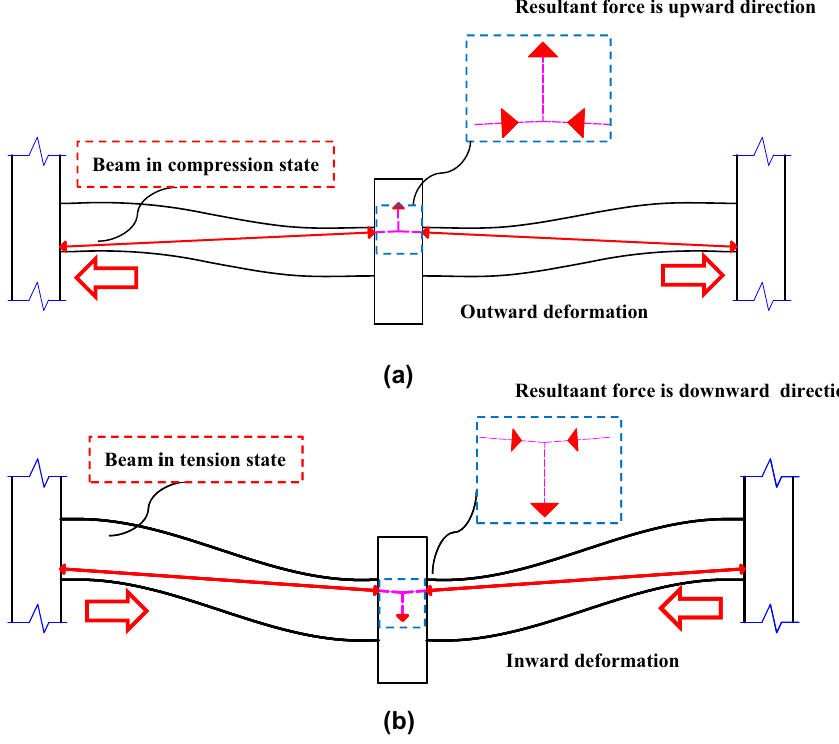
Figure 10: Schematic of the bene fi cial and adverse compressive arch actions to the resistance force: ( a ) bene fi cial action before vertical displacements of 26.7 and 82.7 mm for S1 and S2, respectively and ( b ) adverse action owing to the vertical displacements of 222.3 and 206.5 mm for S1 and S2,